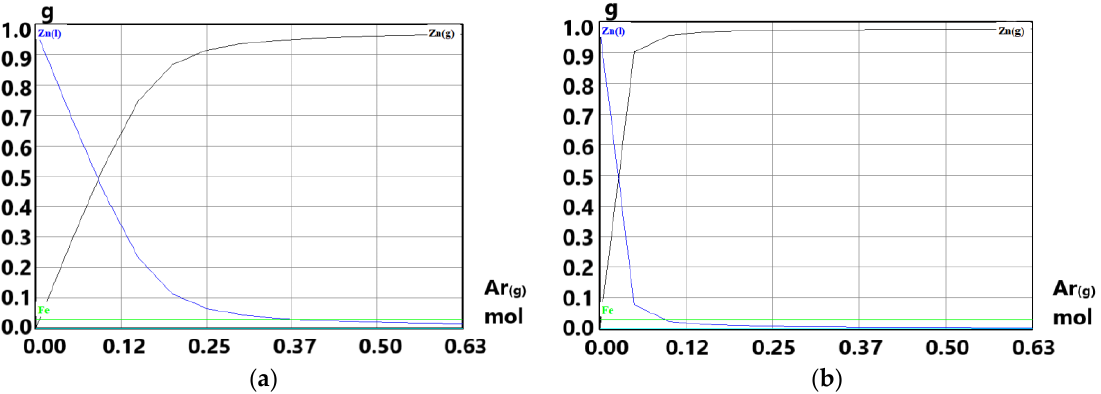
Figure 6. Comparison of dependence of Zn(g) equilibrium partial pressure on the Ar amount in system (1 g Zn: 0.03 g Fe: Ar): ( a ) under the temperature of 700 °C and ( b ) under the temperature of 800 °C. Condensed phases are impure (a ≠ 1).